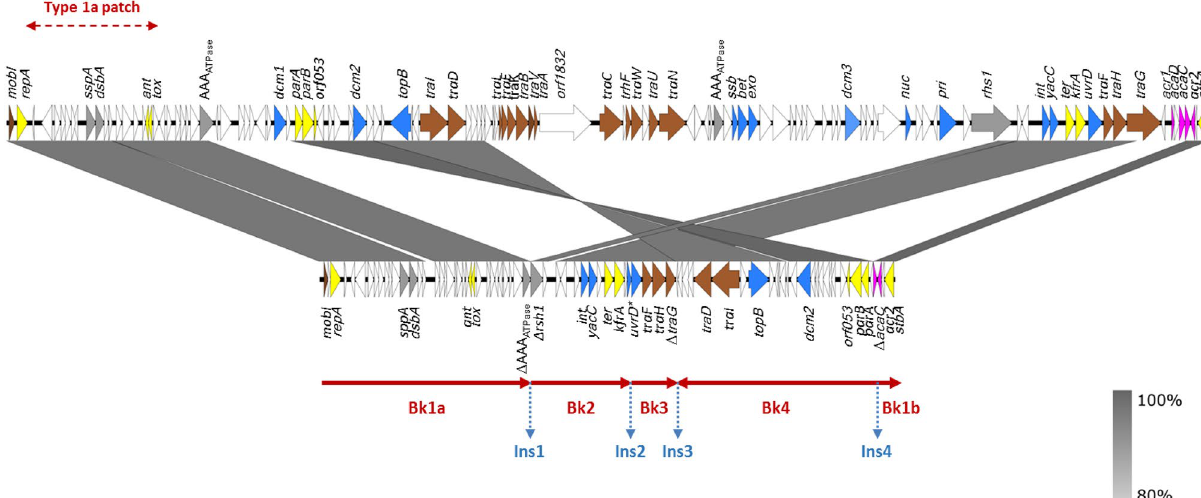
Figure 2. Comparison of the pUO-STmRV1 backbone (below) with that of plasmid pR148 used as reference of the IncC group (above). The alignment was created with EasyFig BLASTn, based on accession no. JX141473 and CP018220. Open reading frames are represented by arrows pointing in the direction of transcription and having different colors based on the predicted functions: yellow, plasmid replication, maintenance and segregation; brown, conjugative transfer; blue, DNA metabolism; light orange, regulation of gene expression; grey, other roles; white, unknown function. Gray shading between the backbones connects regions of nucleotide sequence identity ranging from 80 to 100%, according to the scale shown in the lower right part of the figure. The extent of the four segments of the pUO-STmRV1 backbone (Bk1a and Bk1b, contiguous in the circular plasmid, Bk2, Bk3 and Bk4; the later translocated and inverted with respect to the corresponding segment in pR148), and the position of the insertions located between them (Ins1 to Ins4) are indicated. The uvrD gene, interrupted by Ins2 and distributed between Bk2 and Bk3, is marked with an asterisk and represented by two arrows, corresponding to the 5 ′ - and 3 ′ -ends. The type 1a patch used to differentiate type 1a and type 2b IncC plasmids is shown above the pR148